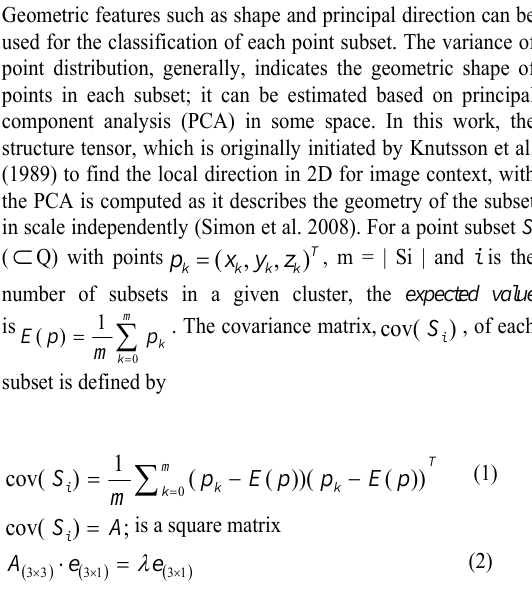
Table 1. Shape indices and Geometric features ( e 0 , e 1 and e 2 are Shortest, Intermediate and longest eigenvectors respectively. e 0 indicates the normal vector of a subset and the normal vector’s Z component is Z n ); L